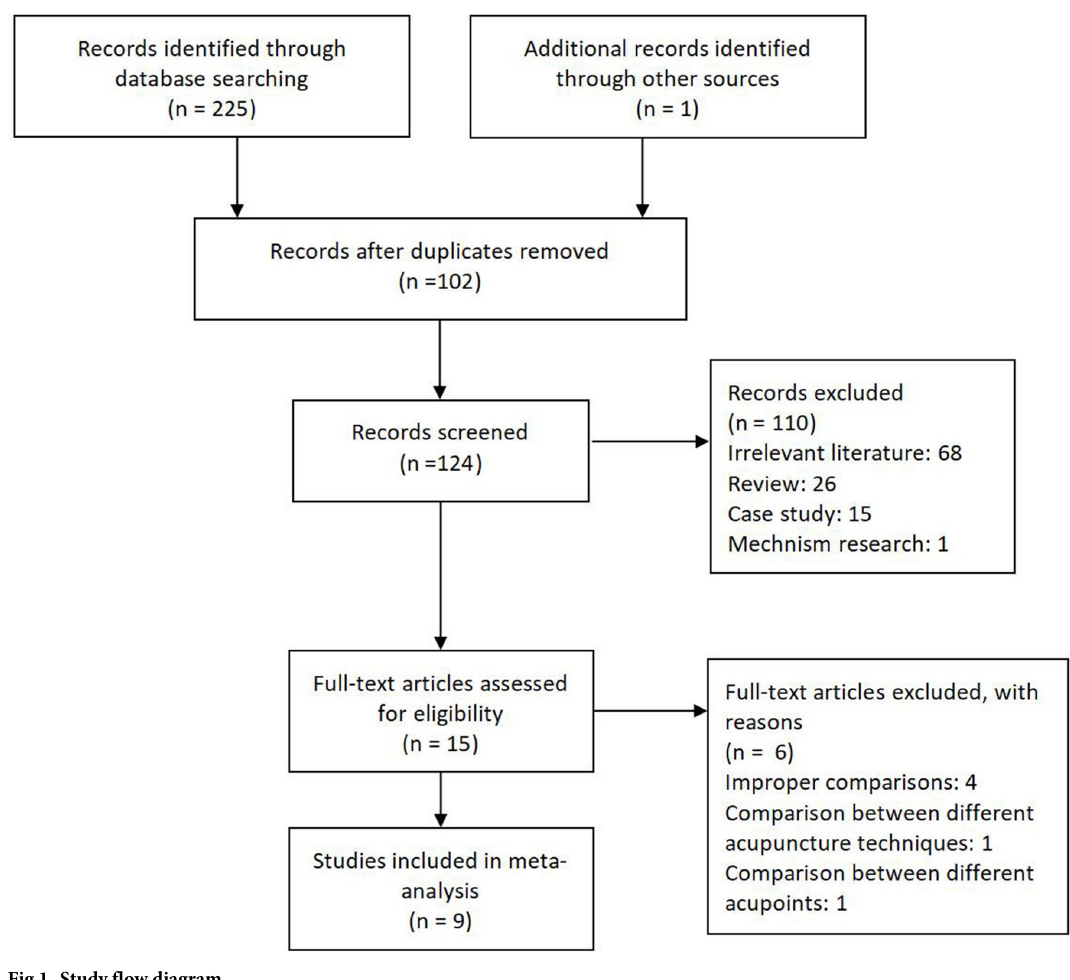
Fig 1. Study flow diagram.